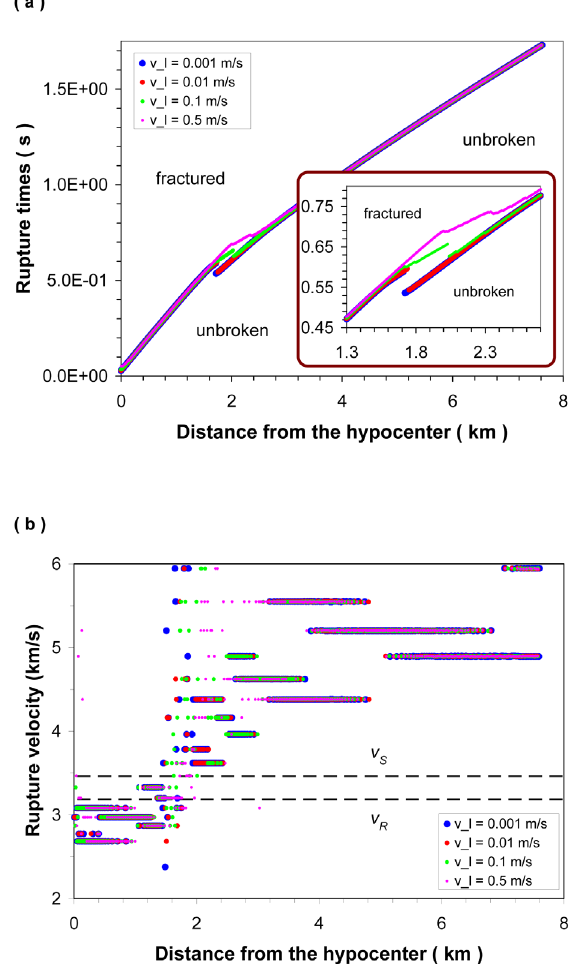
Figure 7. Sensitivity of the determination of the rupture times t r from the choice of the threshold velocity v . The simulations pertain l to 2–D ruptures having the parameters of Table 1, but different val- , as listed in the legends. (a) Distribution of t as a function ues of v l r of the distance from the imposed hypocenter, with an inset report- ing a zoom in the correspondence of the rupture tip bifurcation. At a given rupture time, the fault nodes at distances larger than the lo- cation of the symbols are not rupturing (unbroken parts). (b) Re- sulting rupture speeds, compute by adopting the central scheme at second order of accuracy (which has been proved to be the best ≥ 0.1 m/s the bifurcation computational approach). Note that for v l (jump) of the rupture front is not well resolved and correspondingly and v are also re- the forbidden region is penetrated (values of v R S ported dashed horizontal lines). The results are independent on the ≤ 0.01 choice of the threshold velocity for v l